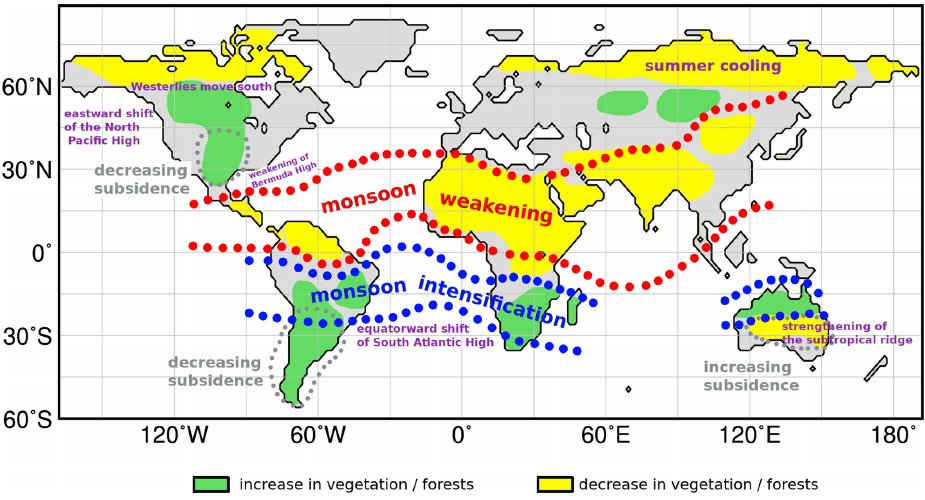
Figure 15. Summarizing sketch of the main vegetation, climate and circulation changes from 8ka to 2.15ka. South of 60 ◦ N, the vegetation trend positively correlates with the precipitation trend, i.e. regions with an increasing vegetation and/or forest fraction during the Holocene experienced increasing precipitation, and vice versa for regions with decreasing